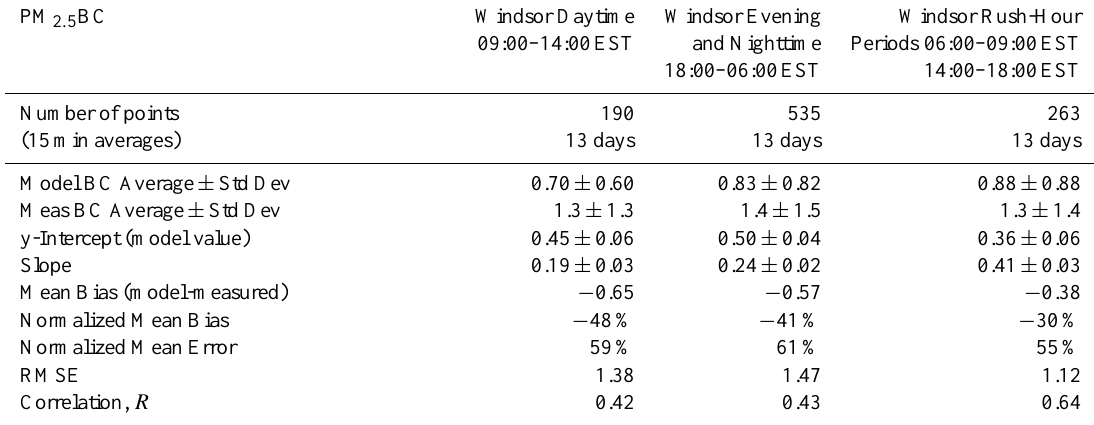
Table 6. AURAMS PM 2 . 5 BC model performance statistics for the 2.5-km grid for the urban Windsor site (concentrations in µgm − 3 ) . PM 2 . 5